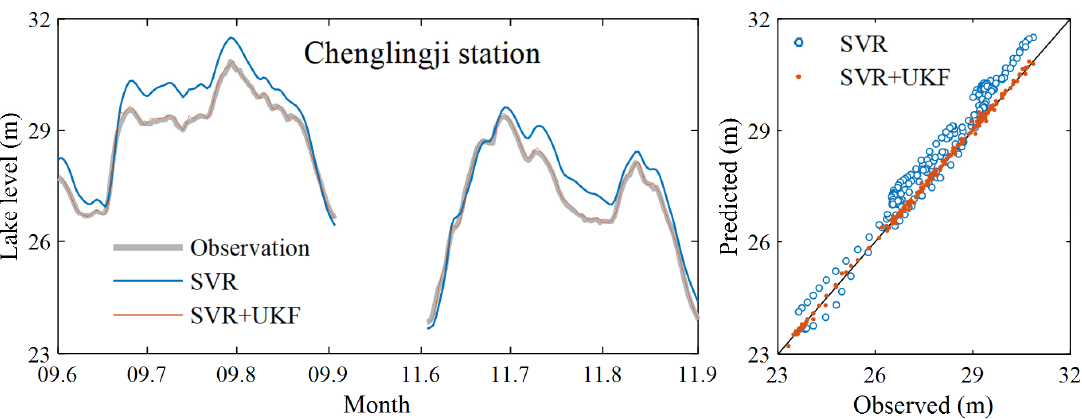
Figure 9. Comparisons between peak water levels in Chenglingji predicted with SVR and SVR+UKF.